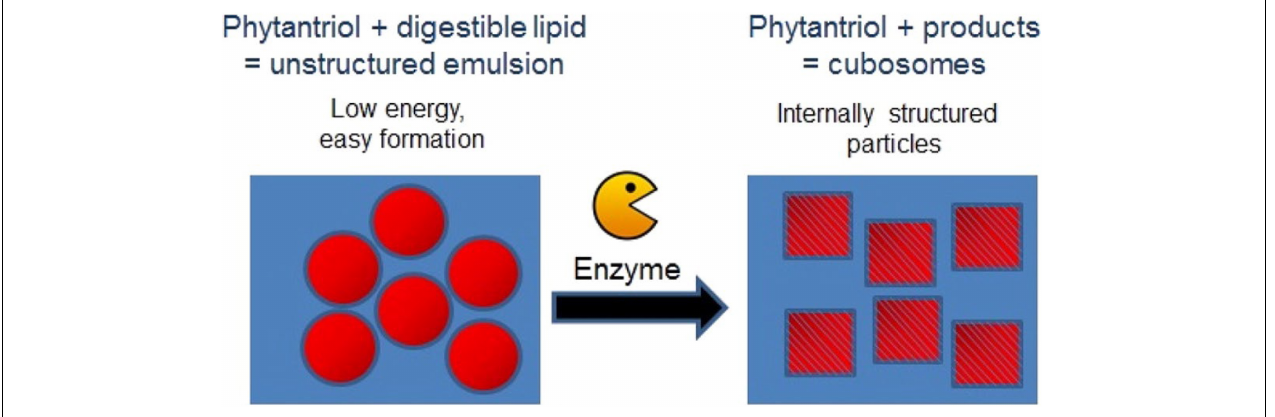
FIGURE 9 | Schematic diagram demonstrating the enzymatic approach to form mesophases particles using a precursor formulation comprising phytantriol and a digestible lipid. Only low energy is required to generate the precursor formulation, in which the digestible lipids partition out of the formulation under digestion to enable the formation of the internally structured particles. Adapted with permission from Fong et al. (2014). Copyright (2014) American Chemical